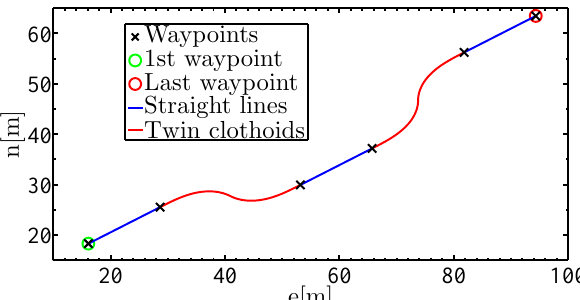
Figure 5: Example of path using interpolating